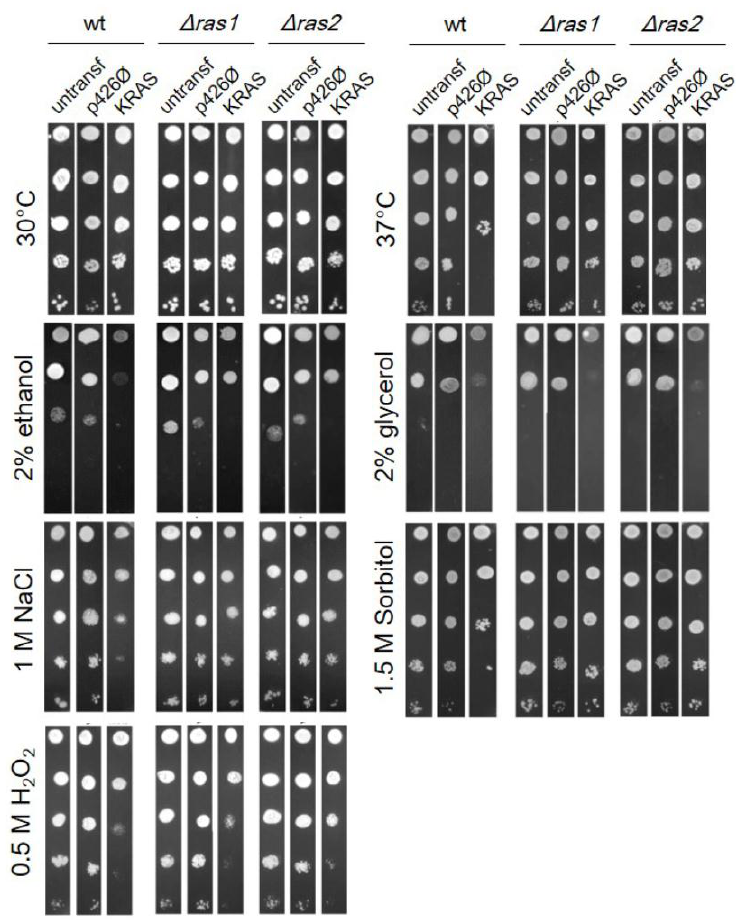
Figure 11. Serial drop test of BY4741 strain expressing human KRAS. S. cerevisiae BY4741 wt, ∆ ras1 and ∆ ras2 were subjected to different stress conditions (stress stimulus described on the side of each box). The direction of the serial dilutions, from 10 − 1 to 10 − 5 , proceeds from top to bottom. The image is representative of one of three independent experiments.